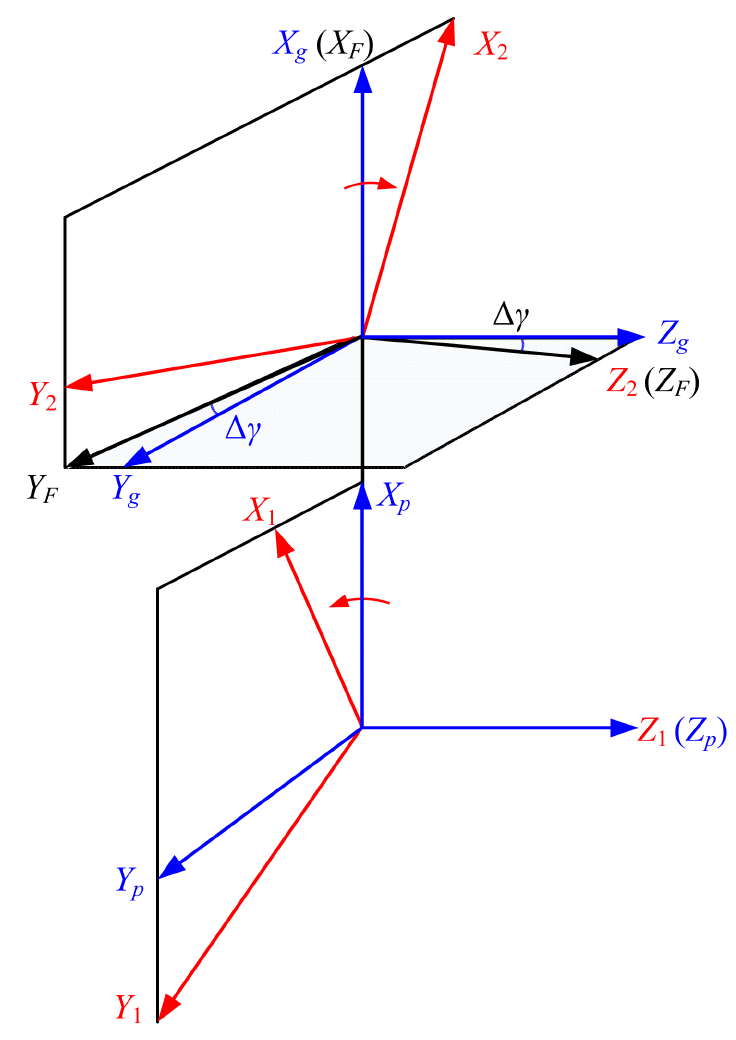
Figure 8. Coordinate systems of meshing gears with misalignment error ∆ γ